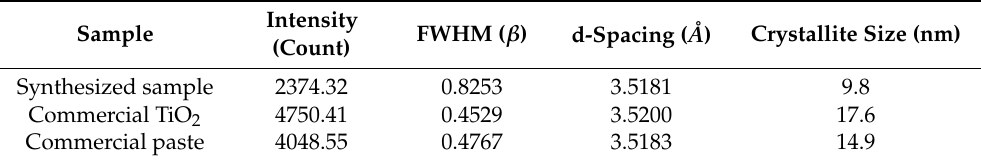
Table 1. The intensity, FWHM, d-spacing and estimated crystallite size of the synthesized sample, the commercial TiO 2 , and the commercial paste based photoelectrode films at the (101) plane of anatase phase.